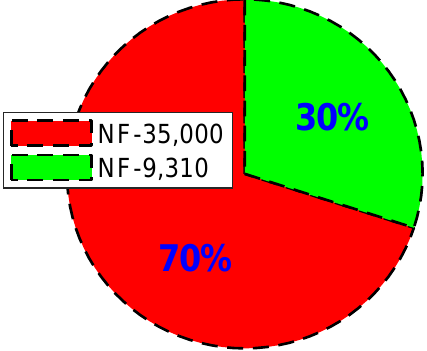
Figure 2. Normal Form (NF) computation time for full and reduced